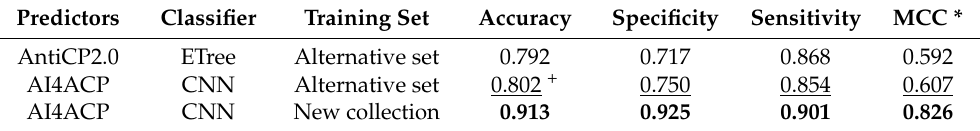
Table 4. Comparison of ACP predictors tested using the testing set of the new collection.